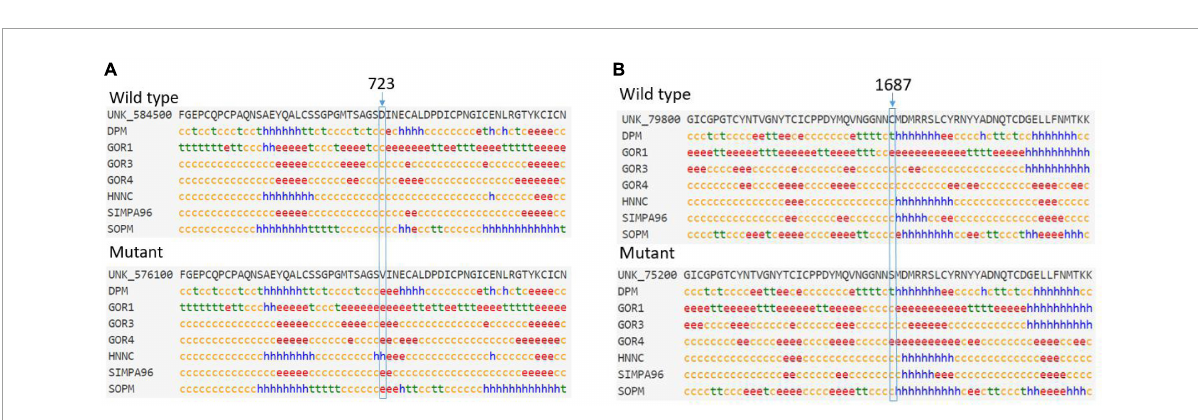
FIGURE4 (A) The predicted secondary structure indicated that an original random coil in the wild-type FBN1 was replaced by an extended strand or alpha helix in the p.Asp723Val mutant FBN1. (B) The p.Cys1687Ser mutant did not cause much change in the predicted secondary structure. c, random coil; e, extended strand; h, alpha helix; t, beta